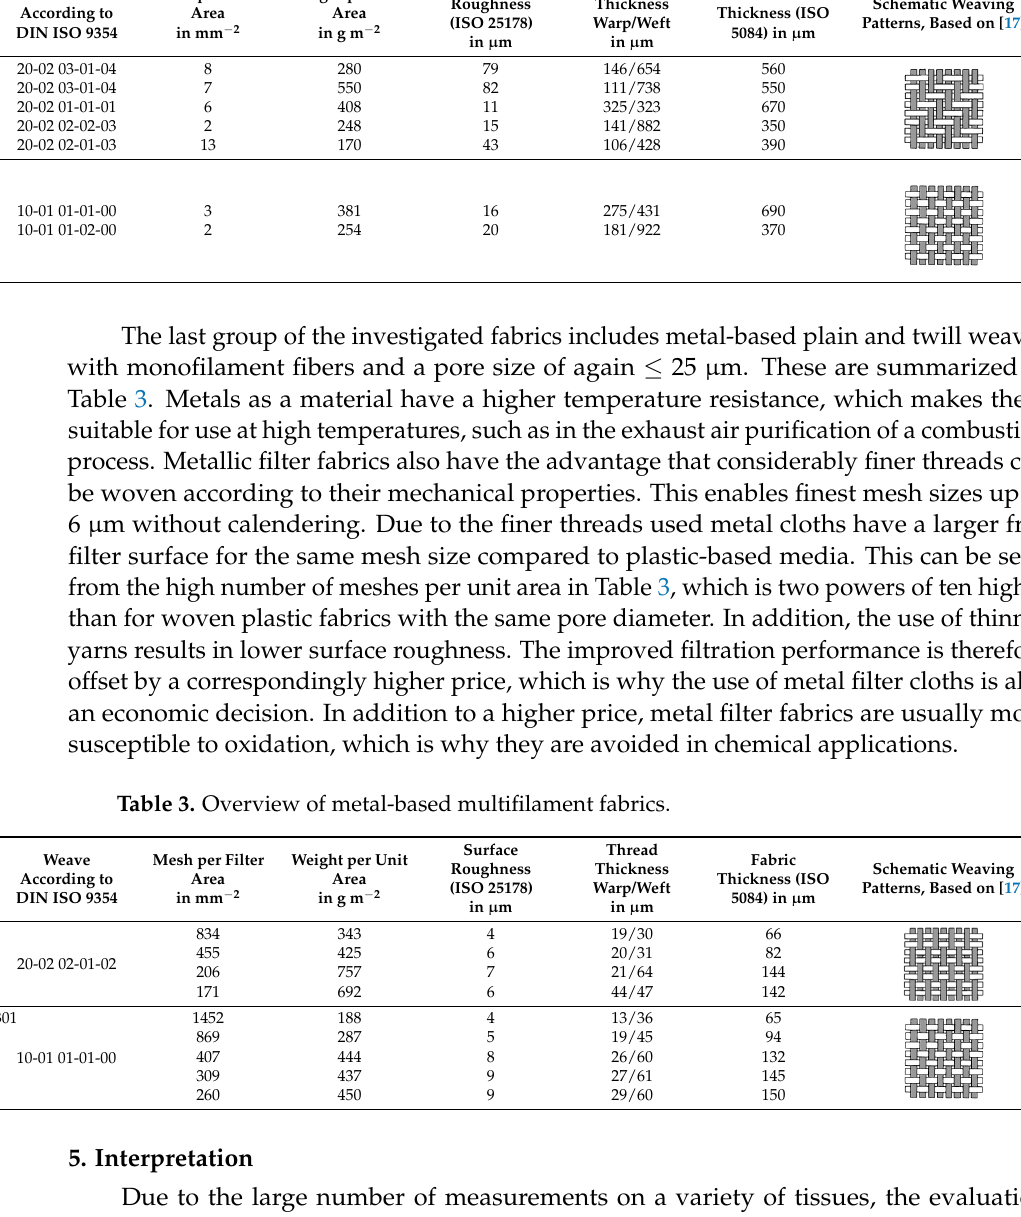
Table 2. Overview of polymer-based multifilament fabrics .